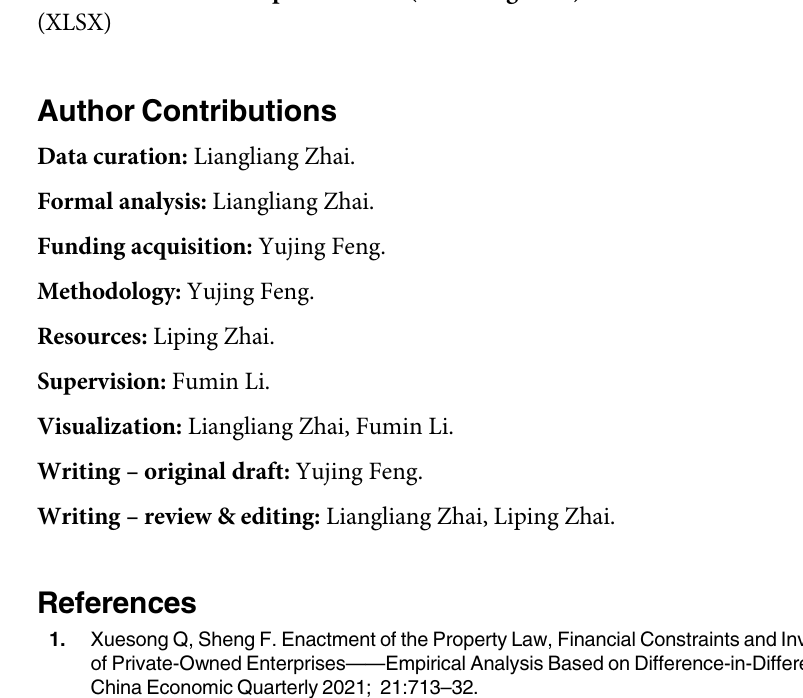
S4 Dataset. Fig 5 Parallel trend test and dynamic effect test. S5 Dataset. Fig 6 Nonparametric stochastic